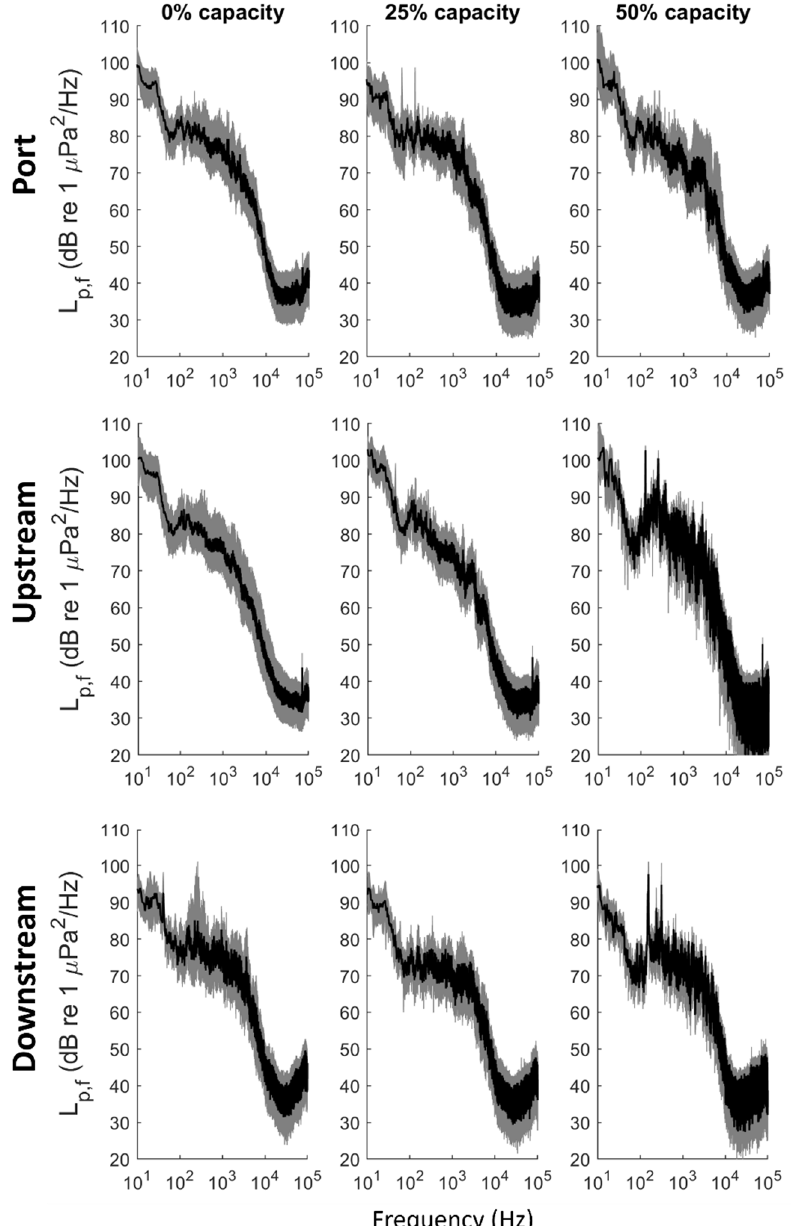
Figure 6. Median values (black curves) and interquartile range (gray region) of the mean-square sound pressure spectral density levels at five rated capacity levels in three 25 m × 25 m zones: port ( top row ), upstream ( middle row ), and downstream ( bottom row ) (see Figure 7). There are no acoustic measurements from the 75% and 100% turbine power generations states, which occurred during the stronger ebb tide of the day in the dark hours before sunrise.